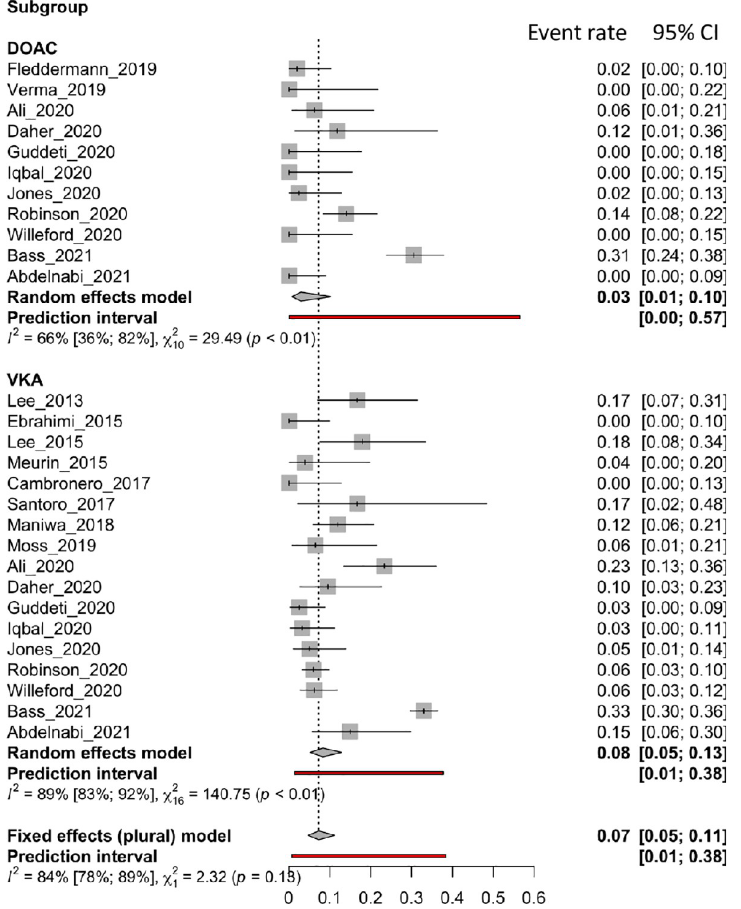
Fig 4. Forest plot of the proportion of any thromboembolism rate for VKA and DOAC therapy.